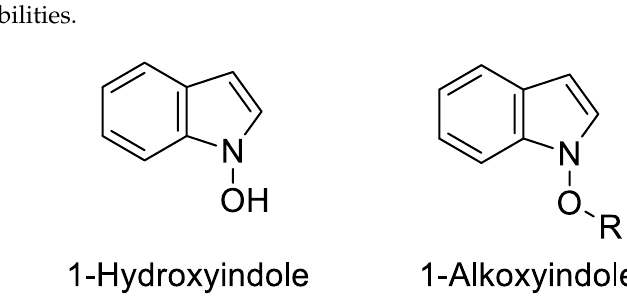
Figure 1. Indole, 1-hydroxyindole, and 1-alkoxyindoles.